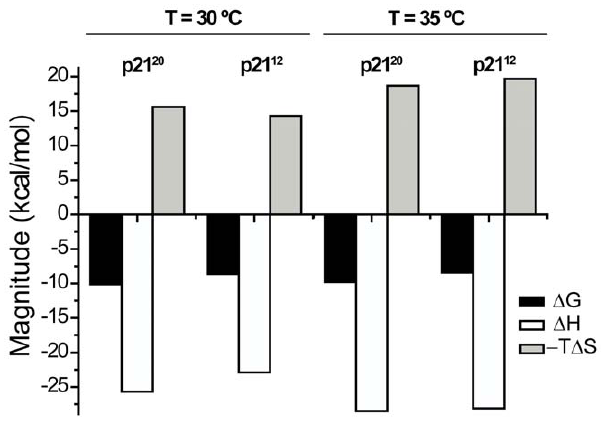
Figure 3. Thermodynamic parameters of the PCNA binding to p21 peptides. The bar diagram shows the change in free energy ( D G), enthalpy ( D H), and in the contribution of entropy to the free energy ( 2 T D S) of the binding of PCNA to the p21 20 and p21 12 peptides, as determined by ITC at two temperatures in PBS pH=7.0. The uncertainty in the experimental values is estimated to be about